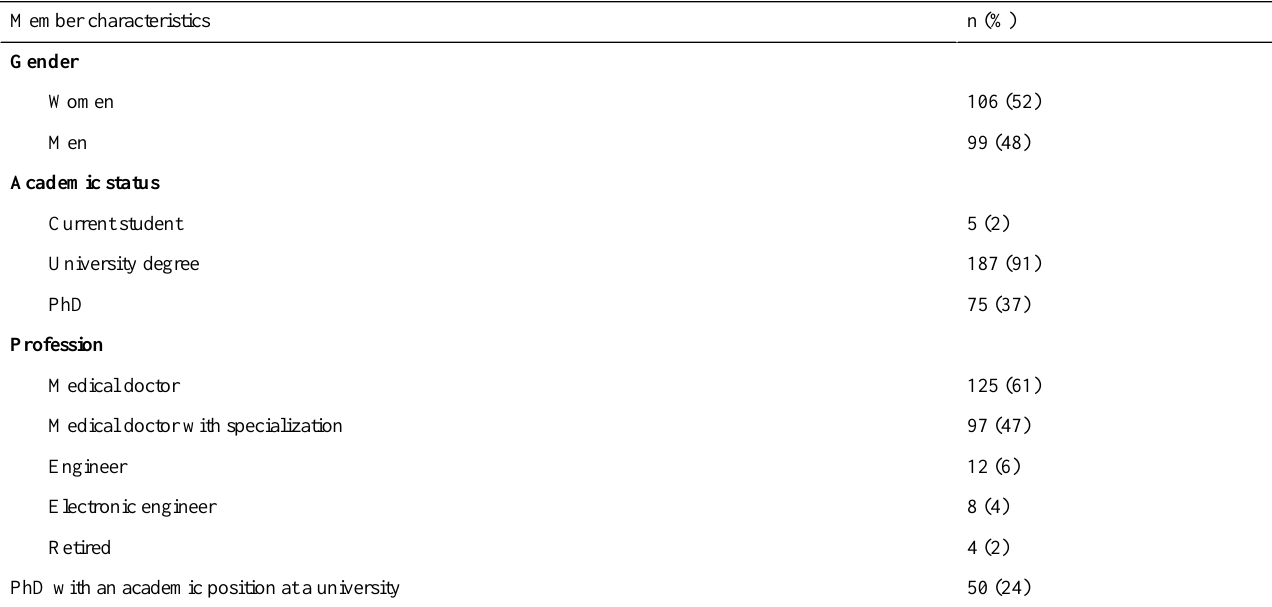
Table 1. Characteristics of the 205 members of the WhatsApp